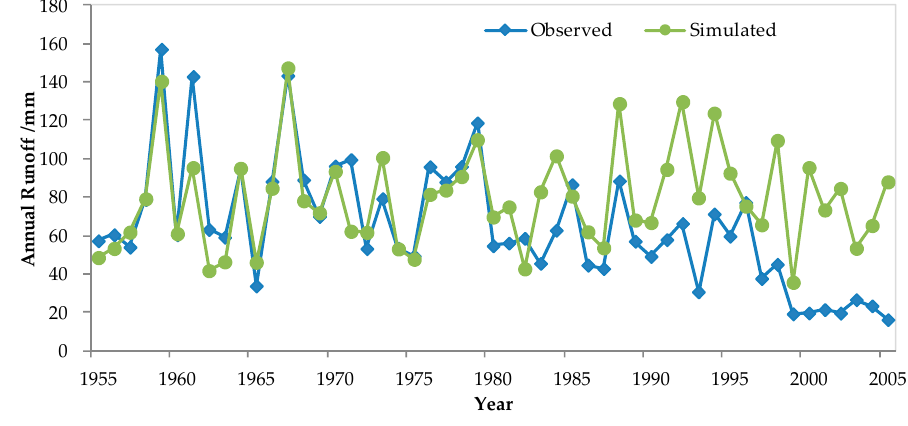
Figure 6. Simulated and observed annual runoff.